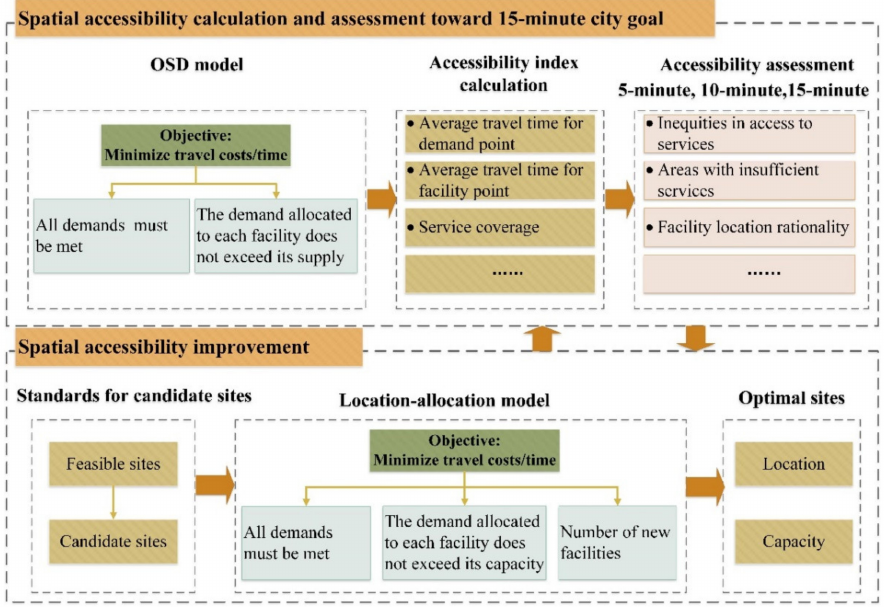
Figure 3. Spatial accessibility assessment and improvement framework toward ‘15-minute city’ goal (created by the